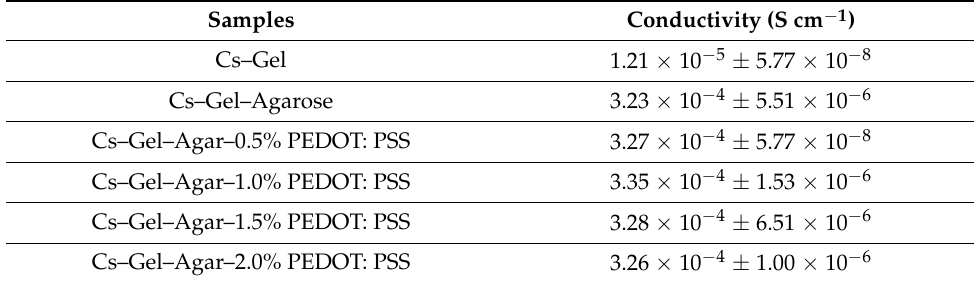
Figure 15. The electrical conductivity plots of all samples. Table 4. The electrical conductivity of solution samples with the addition of agarose in S cm − 1